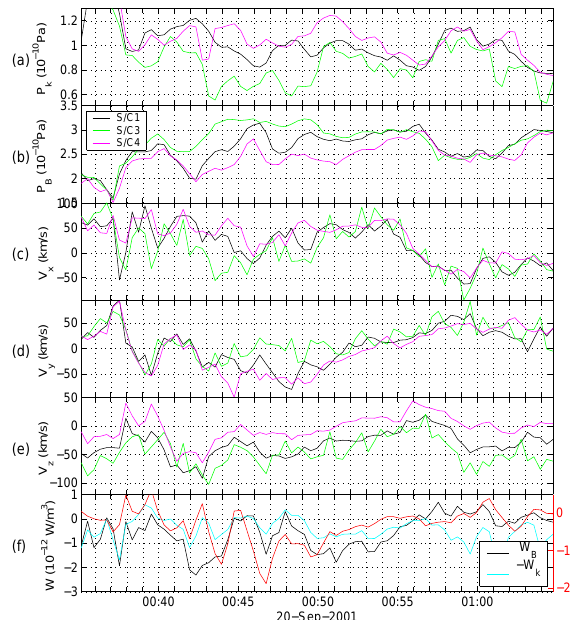
Fig. 8. The same as for Fig. 6 but for CGR3.